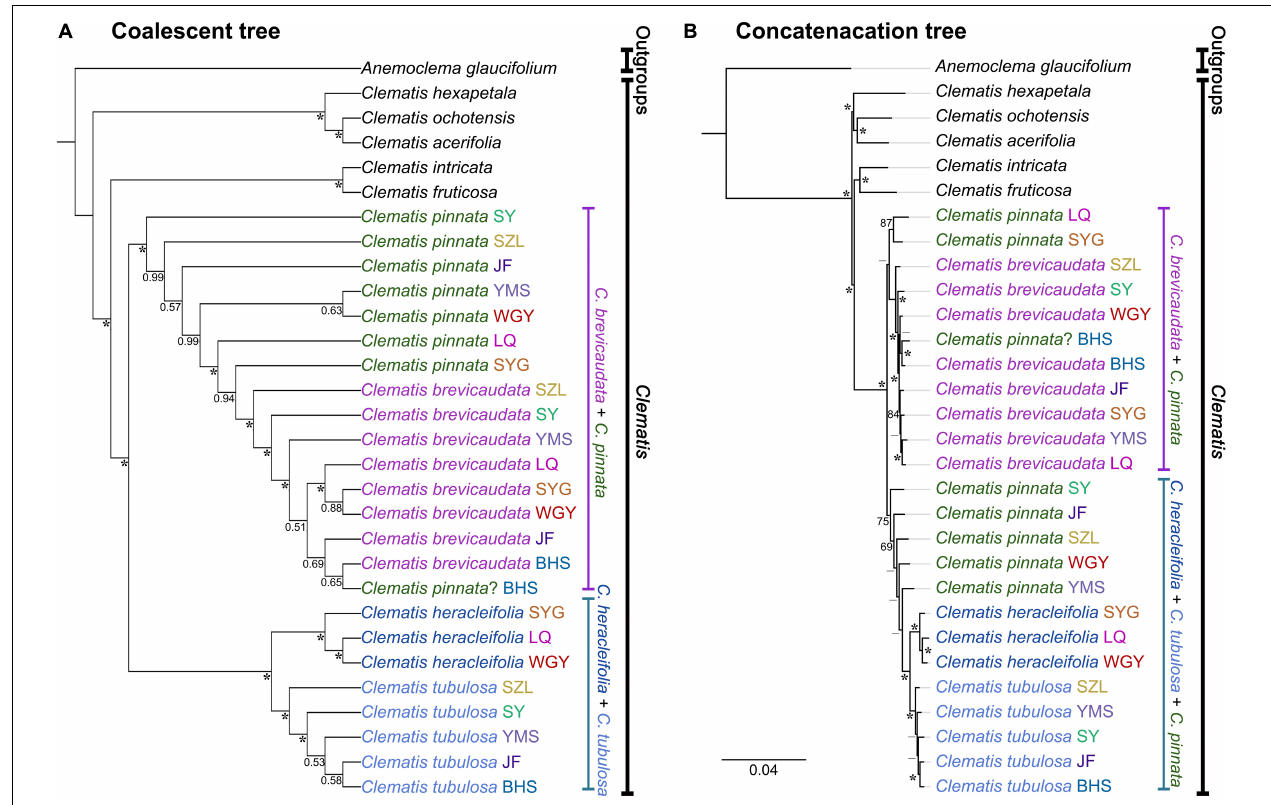
FIGURE 2 | Phylogenetic relationships of eight populations of Clematis pinnata and its close relatives inferred by 3170 co-orthologous nuclear genes using concatenated and coalescent methods. (A) Concatenated phylogeny inferred using maximum likelihood method. Bootstrap percentages are indicated on the branches. * Shows that ML bootstrap values are 100, while – shows that support values are less than 50. (B) Coalescence based species tree, inferred by ASTRAL. Numbers at branches are local posterior probabilities. Local posterior probabilities with values equal to 1.00 were marked with * at branches. Population location name abbreviations are explained in Table 2